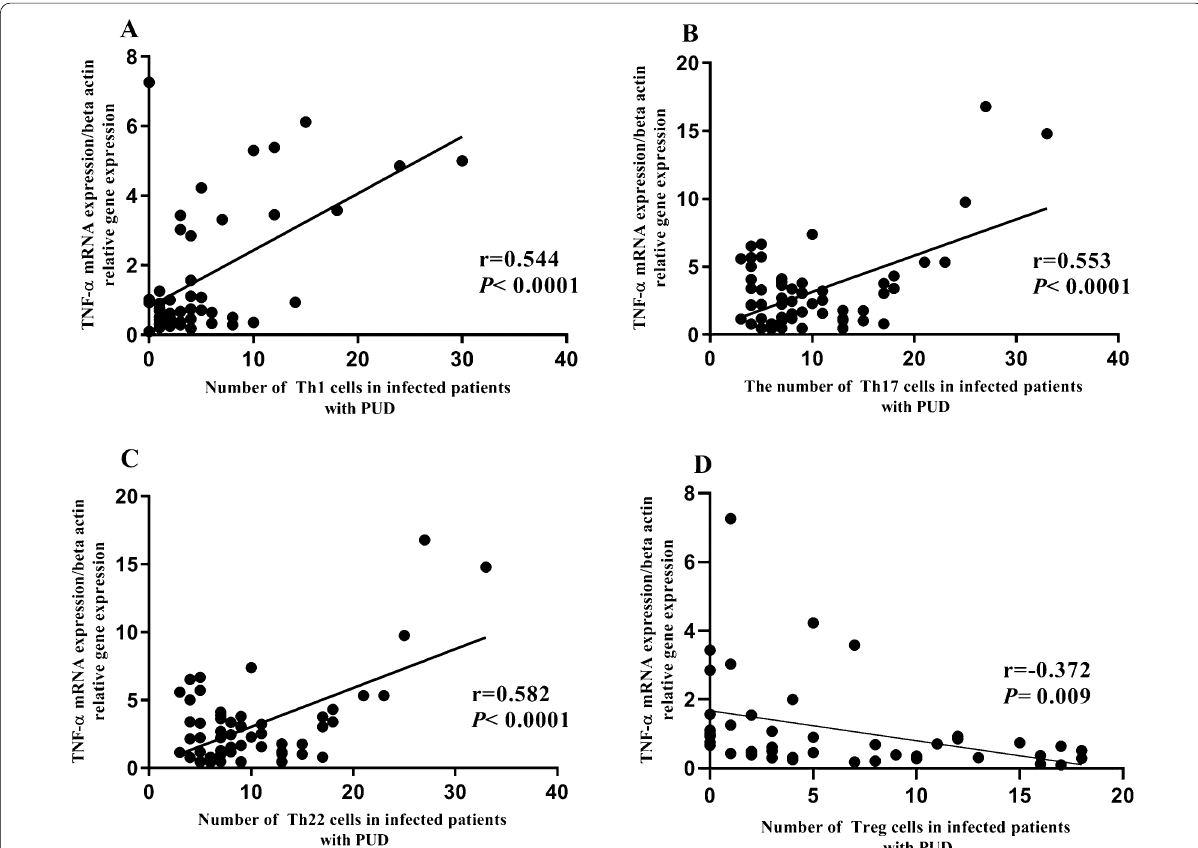
Fig. 8 The association between TNF‑α mRNA expression and the numeral of Th1, Th17, Th22, and Treg lymphocytes in PUD H. pylori ‑positive patients. There was a significant positive association between expression of TNF‑α and frequency of Th1, Th17, Th22 lymphocytes, whilst a significant negative association was shown between TNF‑α expression and Treg lymphocytes in PUD H. pylori ‑positive patients. The data